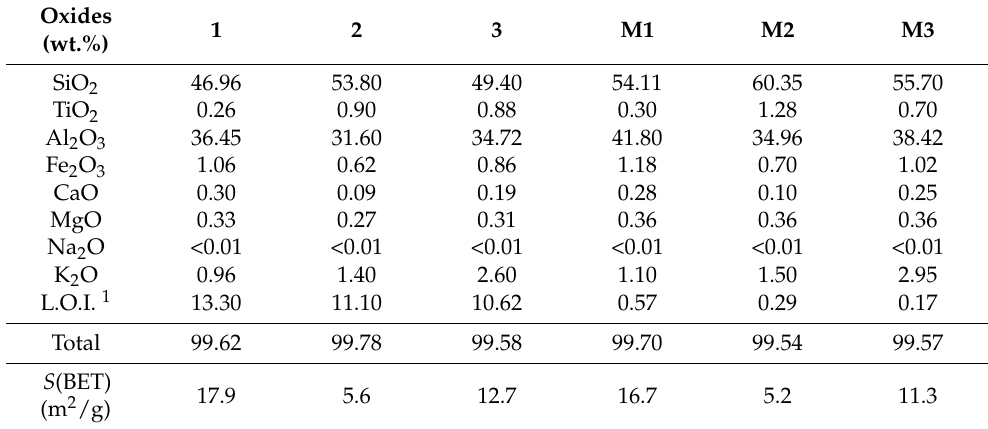
Table 1. The oxides composition of kaolin and metakaolin samples and the specific surface area, S